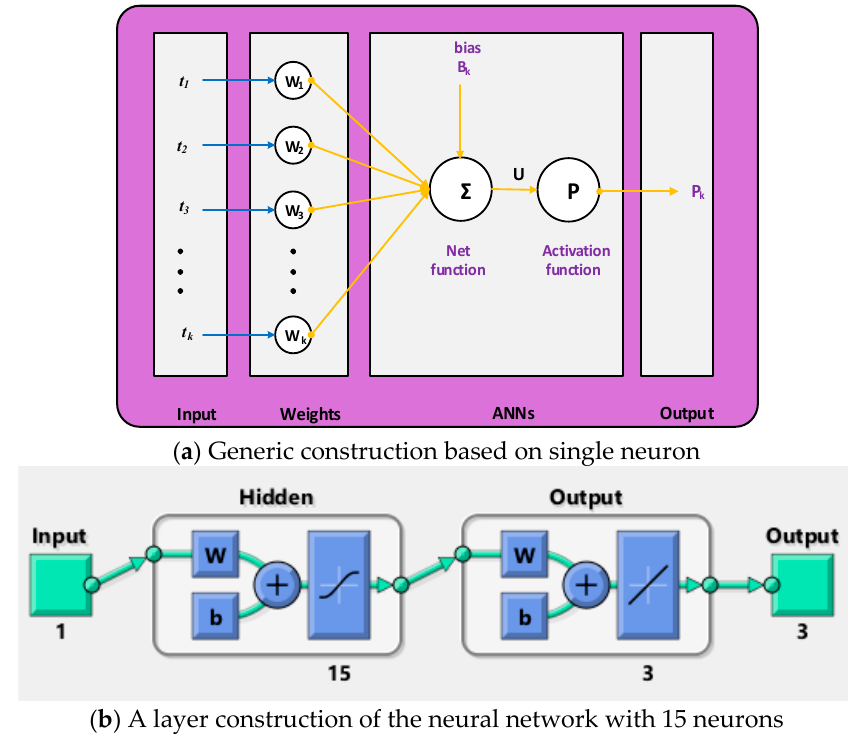
Figure 1. Stochastic illustrations to solve the monkeypox infection system.